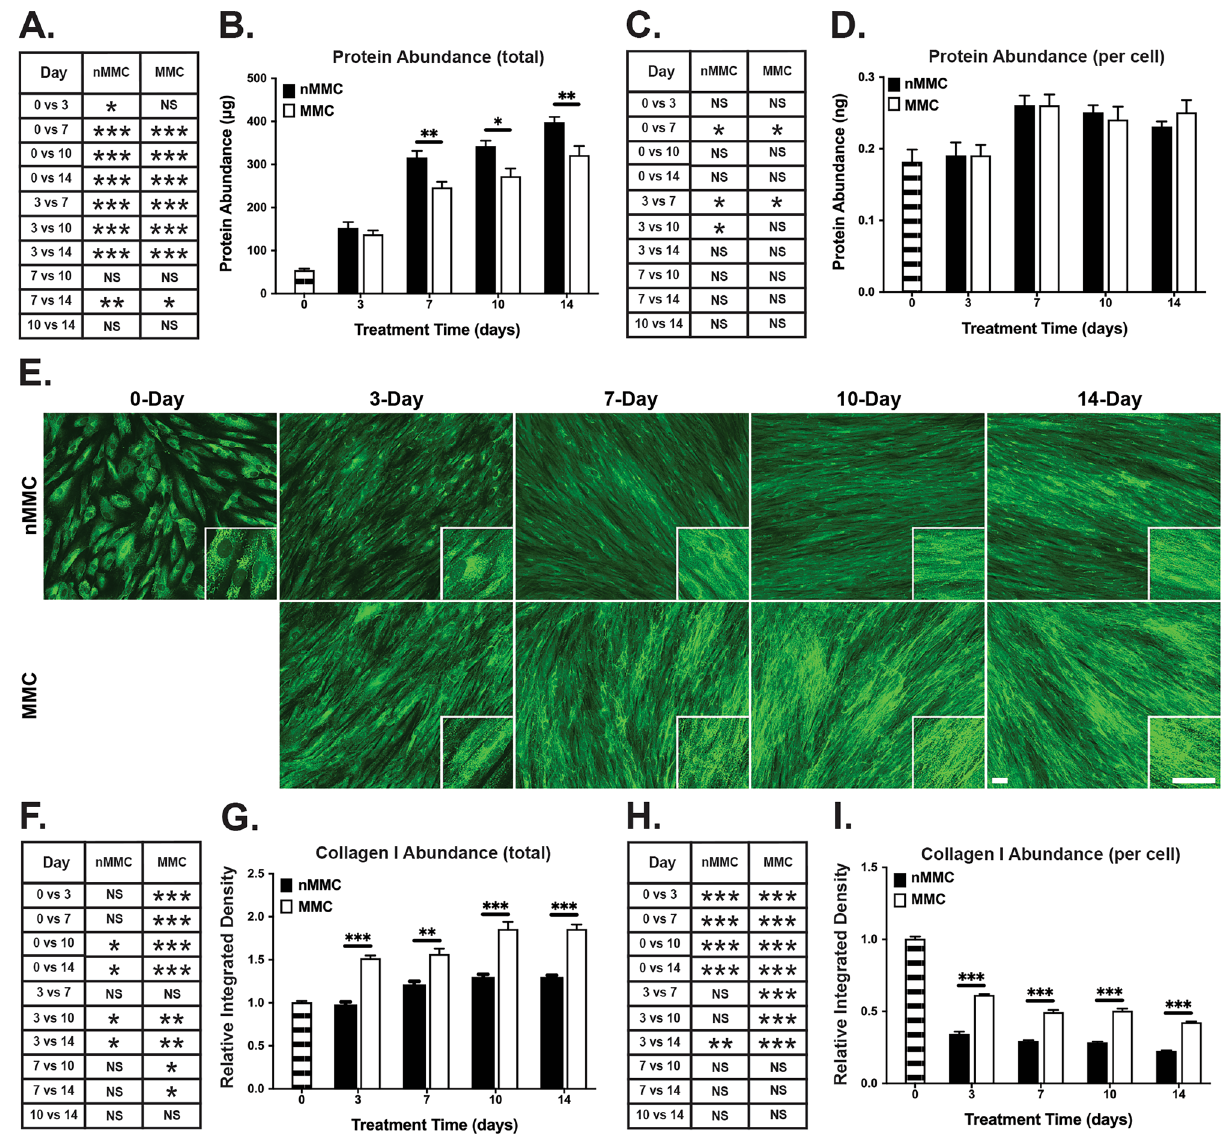
Figure 4. Quantification of total protein amount and characterization of collagen I organization and abundance in MMC and nMMC cultures over time. ( A ) Statistical comparison of change in total protein amount in MMC and nMMC cultures over time. ( B ) Pairwise comparison of total protein abundance at each time point. ( C ) Statistical comparison of change in relative (normalized for cell numbers determined by nuclear DAPI counts) protein abundance over time. ( D ) Pairwise comparison of relative protein abundance at each time point. ( E ) Representative standardized images of collagen I immunostaining from each time point and treatment from two repeated experiments. Inserts show higher magnification of select areas. Images in inserts are individually optimized for brightness/contrast. Magnification bars = 40 μm. ( F ) Statistical comparison of change in total collagen I abundance over time. ( G ) Pairwise comparison of total collagen I abundance at each time point. ( H ) Statistical comparison of change in relative (normalized for cell numbers determined by nuclear DAPI counts) collagen I abundance over time. ( I ) Pairwise comparison of relative collagen I abundance at each time point. Results show mean + /− SEM ( B , D , G , I ) and statistical comparison over time ( A , C , F , H ) from 8 to 11 repeated experiments ( A – D ) and from image analysis performed with 6–12 images obtained from each time point and treatment from two repeated experiments ( F – I ). Statistical testing was performed by one-way ANOVA ( A , C , F , H ) and by independent samples t-test ( B , D , G , I ), *p < 0.05; **p < 0.01; ***p <